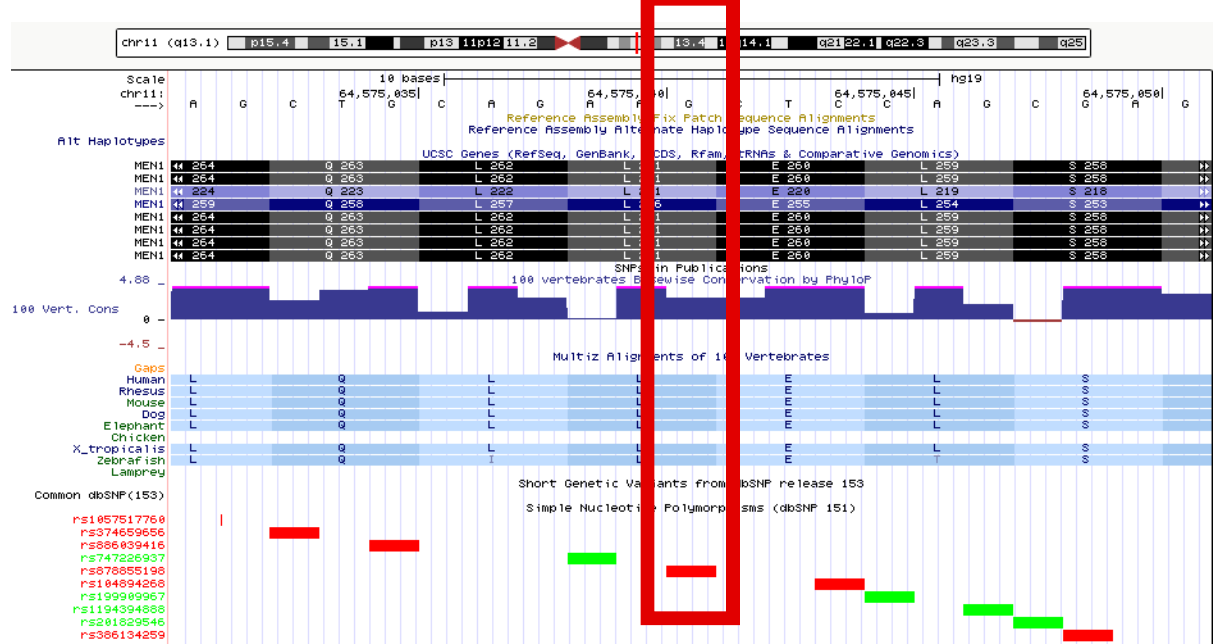
Figure 5. The c.781C>T (p.Leu261Phe) variant visualized in the UCSC Genome Browser (genome.ucsc.edu (accessed on 24 July 2020)), indicated with a red box. Phylogenetically conserved regions according to PhyloP and the alignment across different vertebrate species are shown.